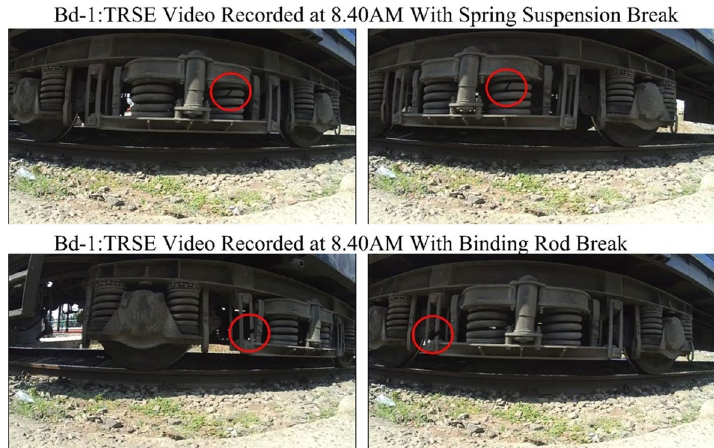
Fig. 6 Defective bogie parts induced into the original video frames through